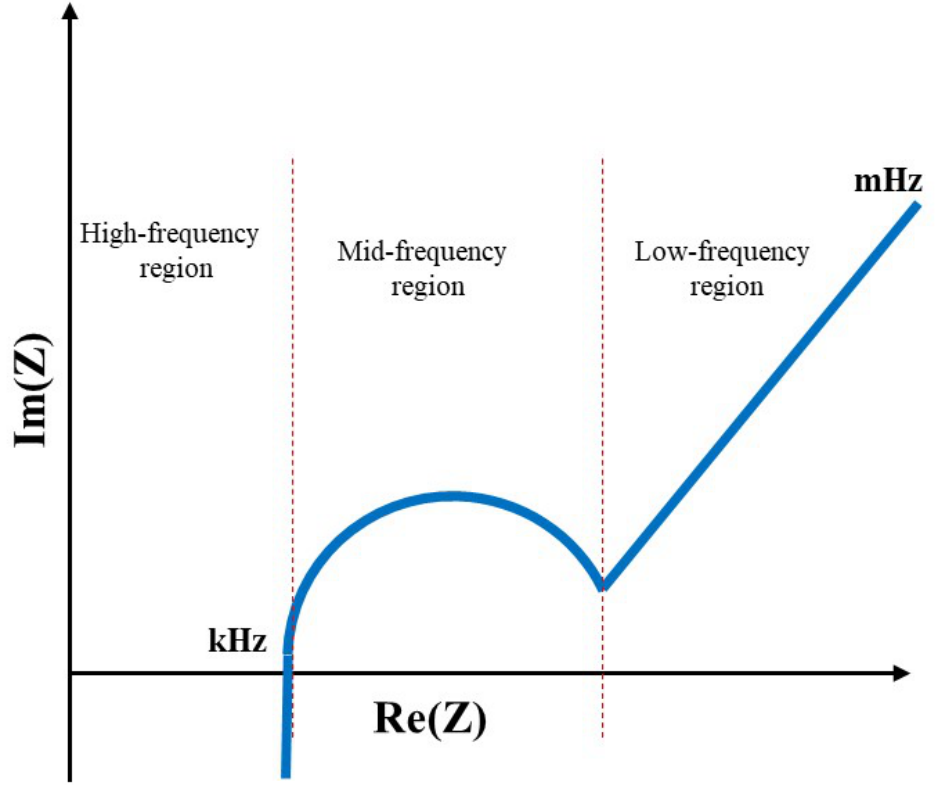
Figure 1. Typical EIS of a lithium-ion battery.